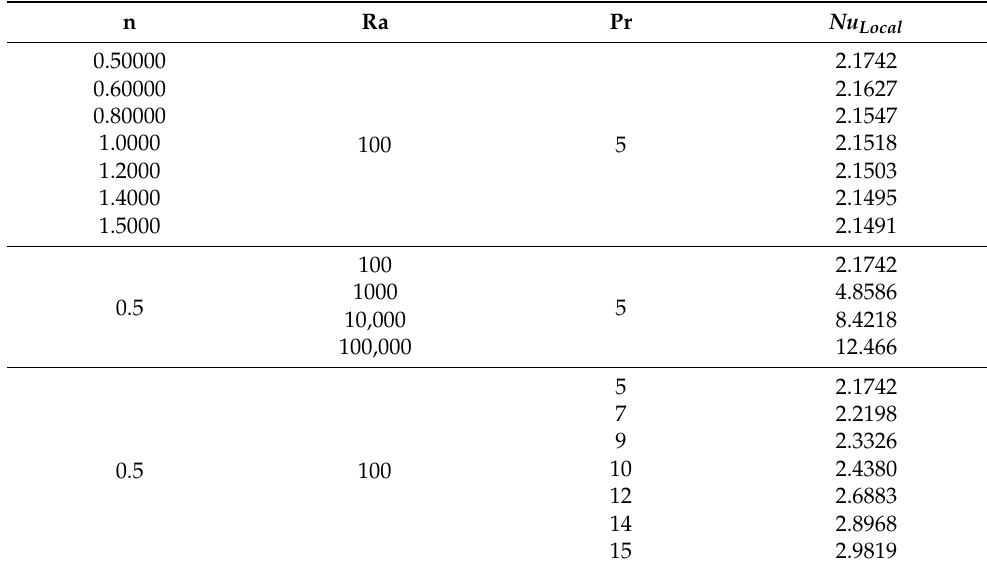
Table 4. Variation in Nusselt number against ( n ) , ( Ra ) and ( Pr ) . n Ra Pr